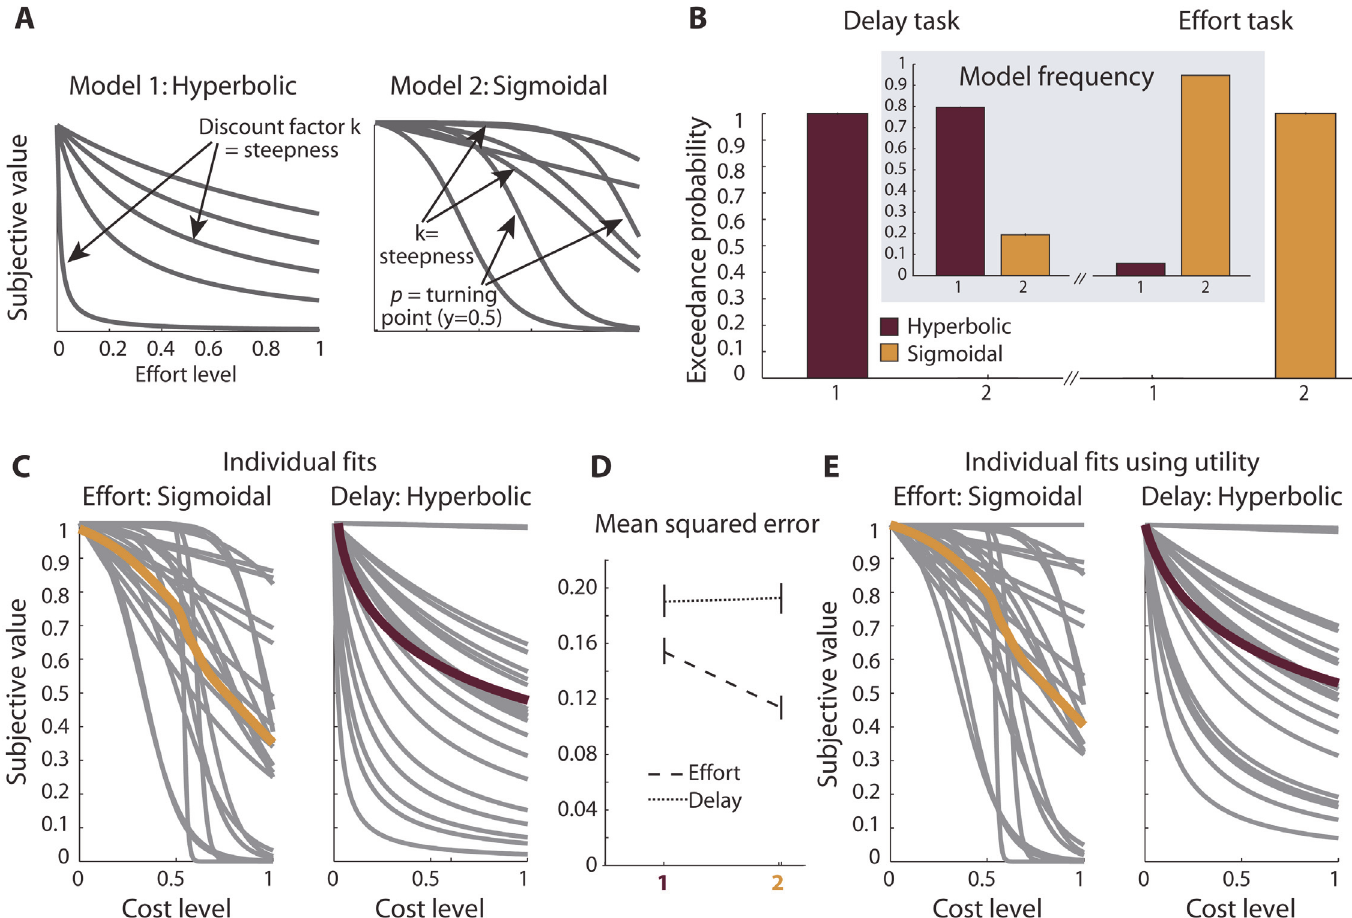
Fig 3. Experiment 1: Comparison of effort and delay discounting. A , Two models were fitted to participants ’ choice data; the hyperbolic model has previously been proposed to characterize effort and delay discounting. The sigmoidal model was included because it fulfills two particular features: it can obtain initially concave shapes, in line with work showing that the sense of effort increases as a power function of the target force with decreasing sensitivity at lower effort levels; and it entails a turning point after which effort discounting becomes progressively less steep. The equations are as follows: hyperbolic: V = M/(1+kC), sigmoidal: V = M (1- (1/(1+exp(-k * (C-p)))- 1/(1+exp(k * p))) (1 + 1/exp(k * p))). B , Bayesian model comparison of the hyperbolic and the sigmoidal model showed a clear dissociation: the hyperbolic model best explained delay-based choices (left), whereas the sigmoidal model best explained effort-based choices (right). C , Individual and average fits of the sigmoidal winning model for effort and the hyperbolic winning model for delay. D , Mean squared error, indicating the goodness of fit of the two competing models for the effort and delay task. E , Individual and average model fits, as in C , but these fits were obtained by using the utility instead of reward magnitude during parameter estimation. This has a negligible effect on the shape of discounting we observe.